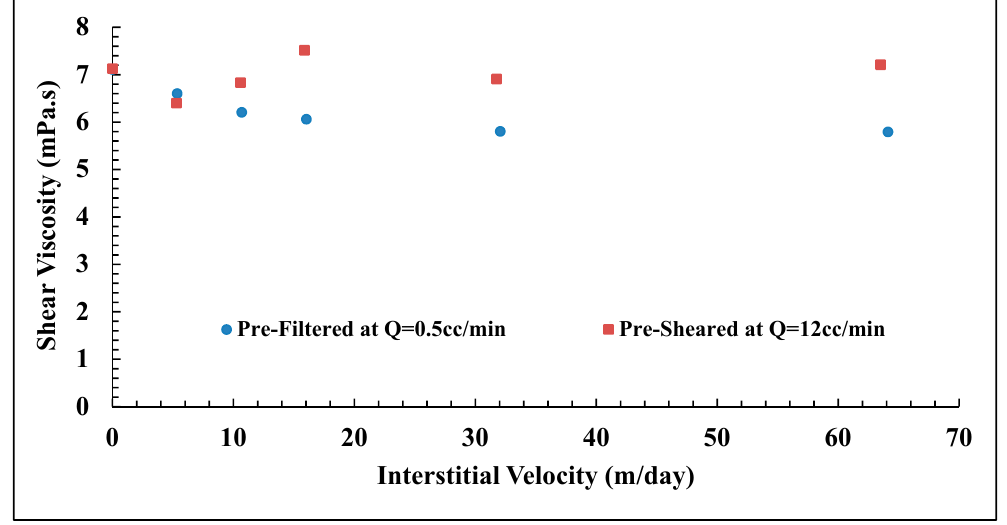
Figure 9. Effluents shear viscosity of Solution A measured at γ(cid:4662) = 10 s (cid:2879)(cid:2869) . Error bars are smaller than the size of each point (±0.20 mPa.s).